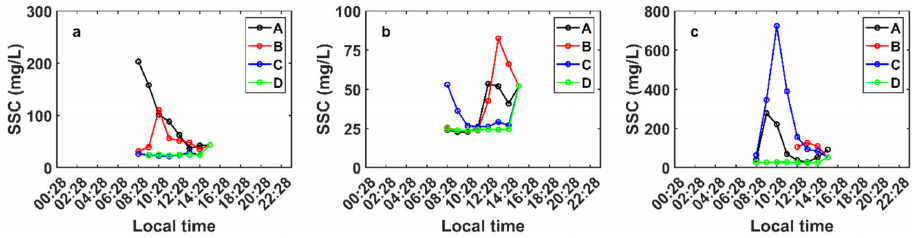
Figure 13. The variations of the SSC at four typical points during neap ( a ), middle ( b ), and spring ( c ) tides, respectively. The SSC was calculated by averaging over a box of 5 × 5 pixels (2 km × 2 km) centered on the selected